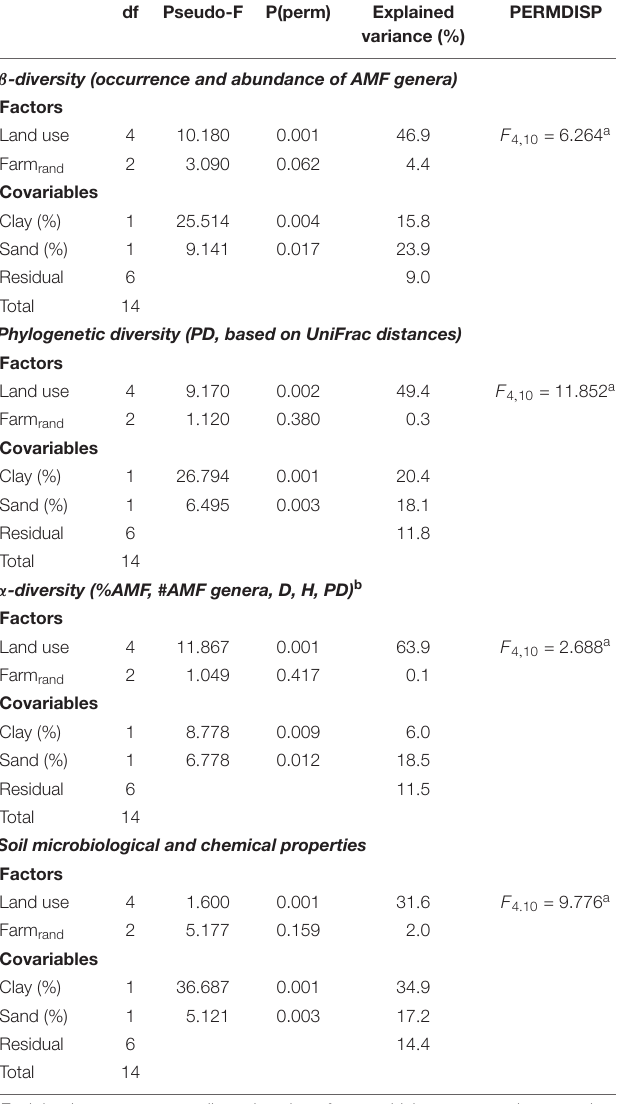
TABLE 2 | Permutational multivariate analyses of variance to test the effect of five land-use types on the composition and structure of arbuscular mycorrhizal fungal (AMF) communities among land-use types ( β -diversity) and within land-use type ( α -diversity), phylogenetic diversity (PD) and microbiological and chemical soil